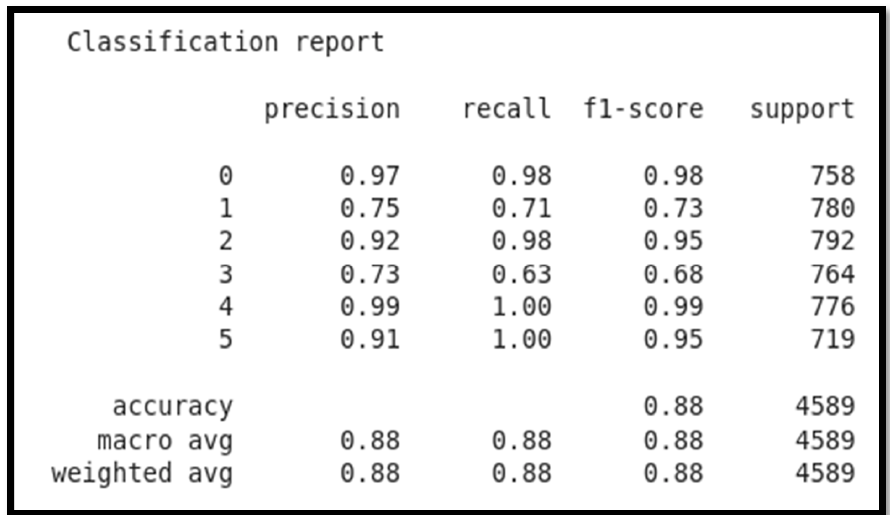
Figure 22. Classification report of logistic regression.